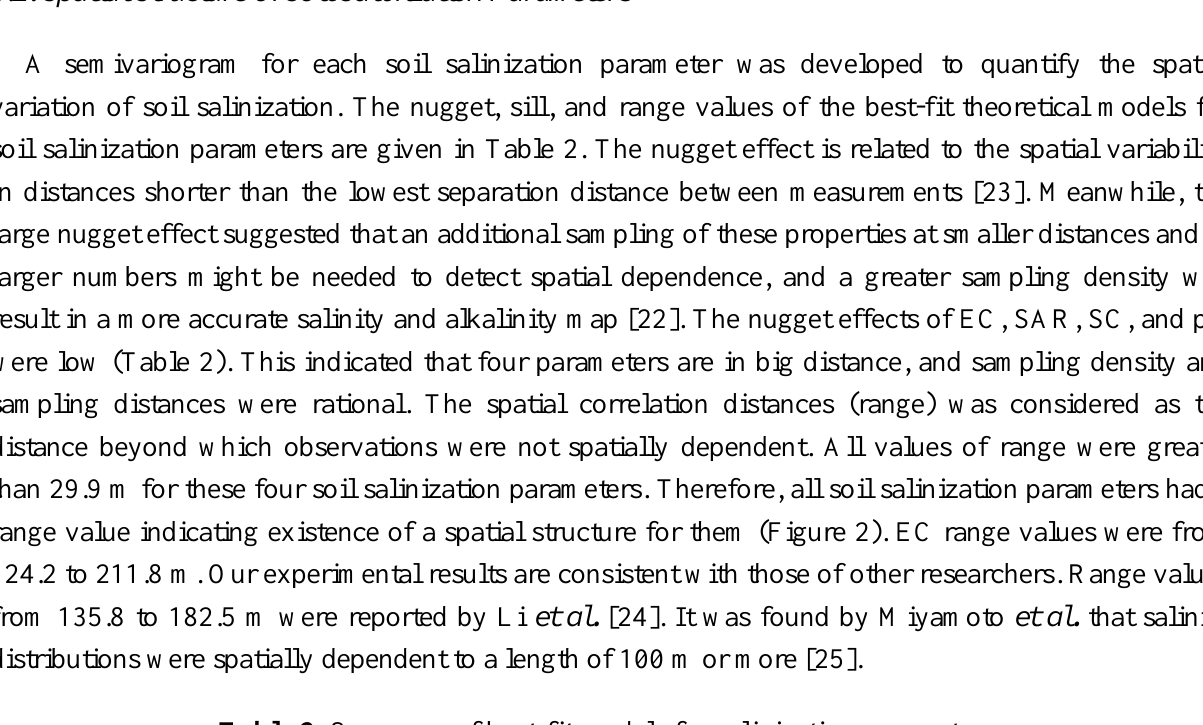
Table 2. Summary of best-fit models for salinization